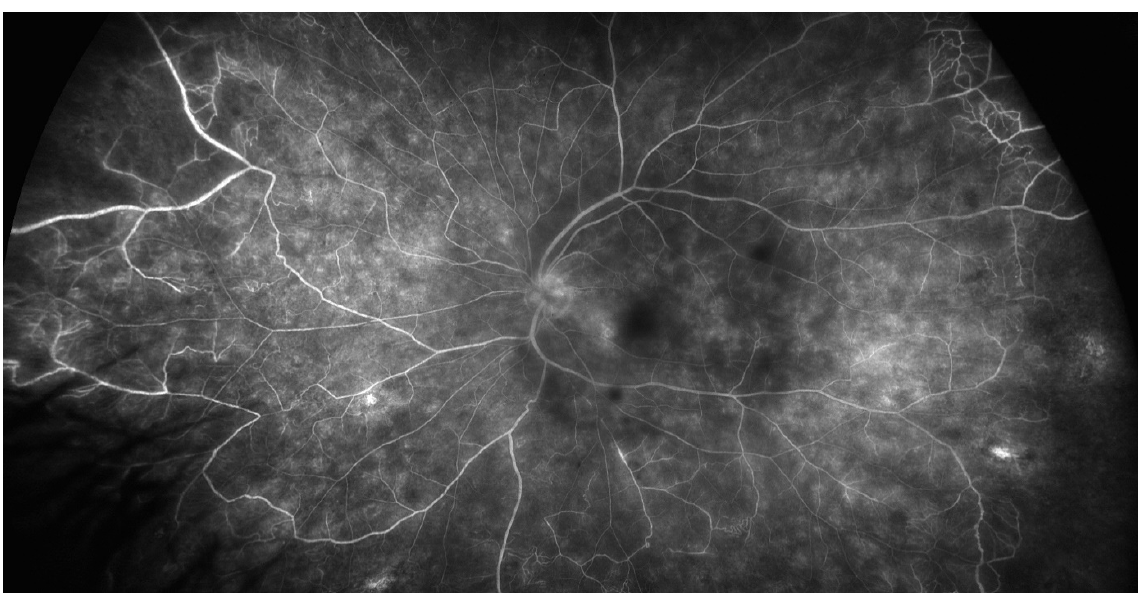
Figure 2. Late phase of ultra-wide field fluorescein angiography showing papillary hyperfluorescence, extensive retinal capillaropathy and peripheral occlusive vasculitis in Behçet’s disease uveitis.